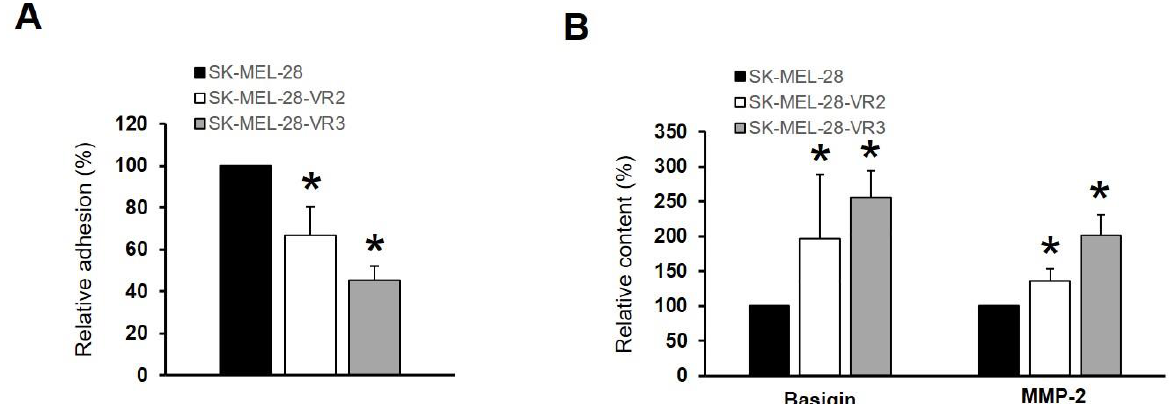
Figure 6. Vemurafenib-resistant cells (VR2 and VR3) showed more disseminative features. ( A ) Decrease of adhesion to extra-cellular matrix facilitated metastatic process. Resistant clones displayed a reduction of adhesion ability. Each point represents the mean ± SD of three different determinations (statistical significance versus control: * p < 0.01). ( B ) CD147/basigin and MMP-2 levels in melanoma cell lines as determined by Luminex assay (statistical significance versus control: * p < 0.01).